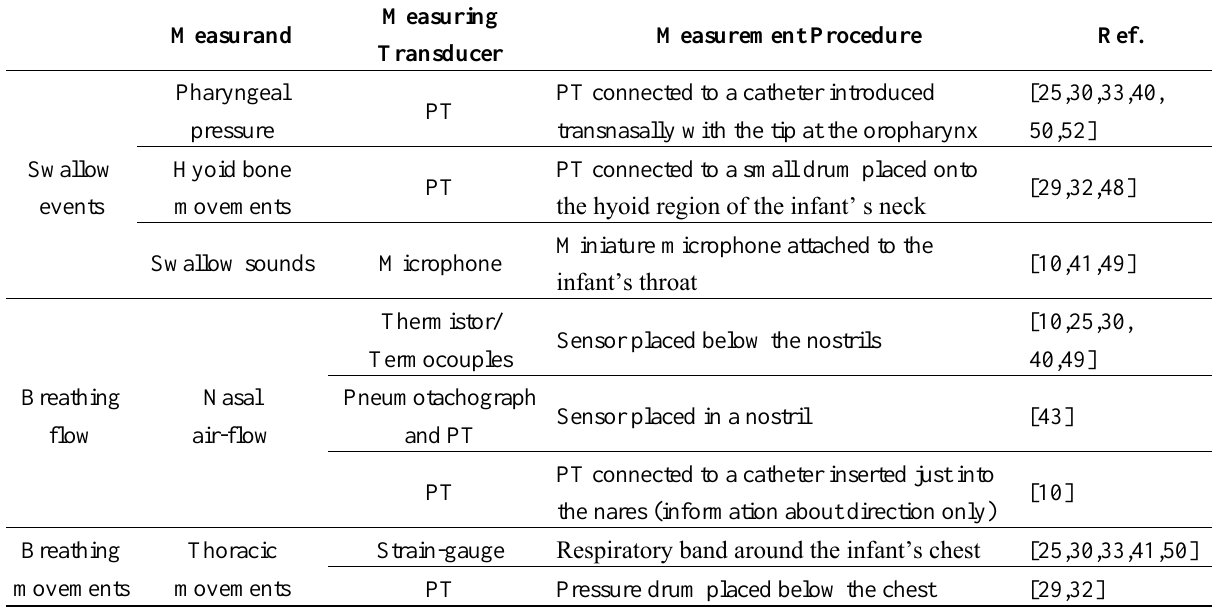
Table 4. Overview of the measuring systems used to monitor swallowing and breathing process: measurands, sensors and measurement procedures.